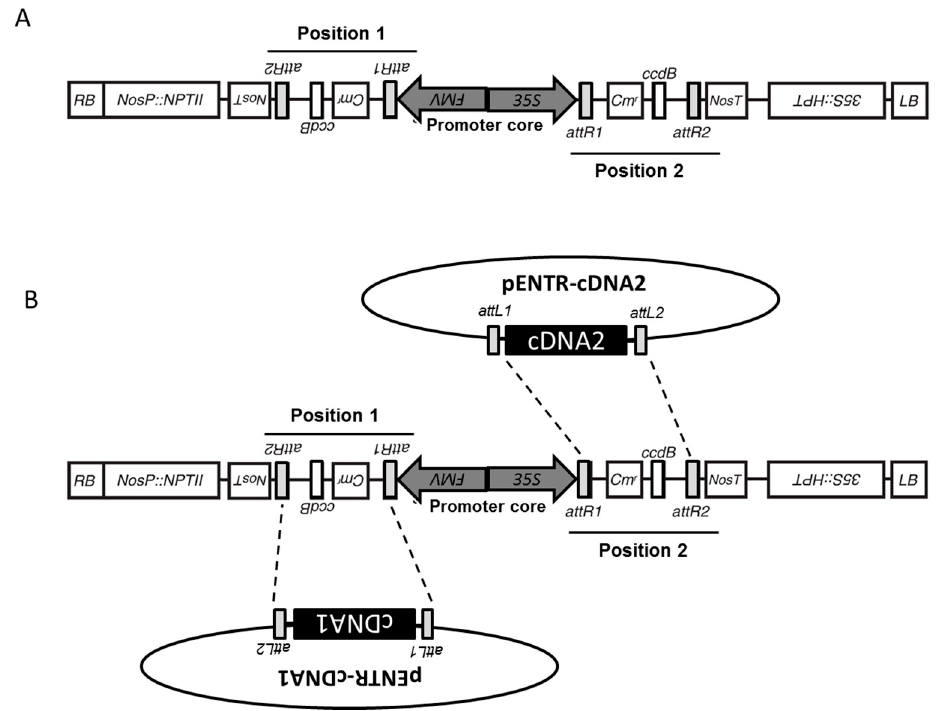
Figure 1. Schematic representation of vector pGEMINI. ( a ) Each of the two positions is represented and the promoter core shows the location of the back-to-back FMV and 35S promoters; ( b ) Schematic representation of LR clonase reaction showing the integration of two independent cDNAs into each clonase cassette.